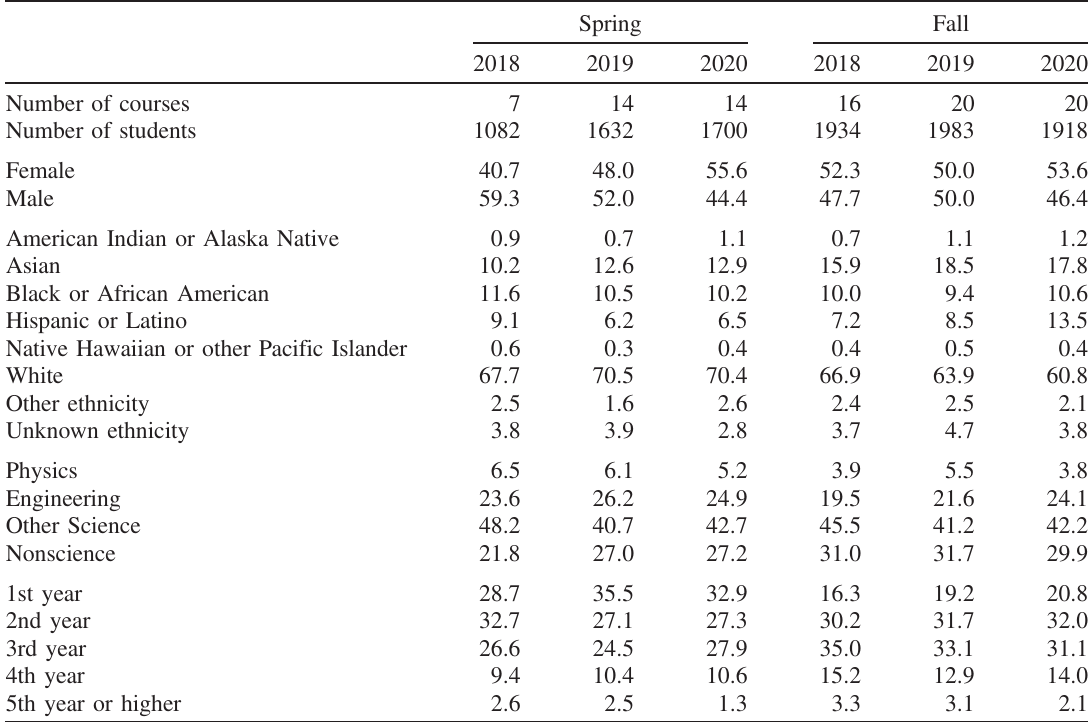
TABLE I. Student demographic information from spring and fall for introductory courses in the years 2018, 2019, and 2020. Courses in 2018 are included only if the same course occurred in 2020 and 2019. Race and ethnicity labels correspond to those used by the U.S. Census Bureau [40]. The category “ Physics ” major includes physics and engineering physics majors only. “ Engineering ” includes all engineering other than engineering physics. “ Other Science ” majors include all other science majors (biology, chemistry, math, computer science, etc.) not included in the physics category, “ Nonscience ” majors include all other majors as well as undeclared